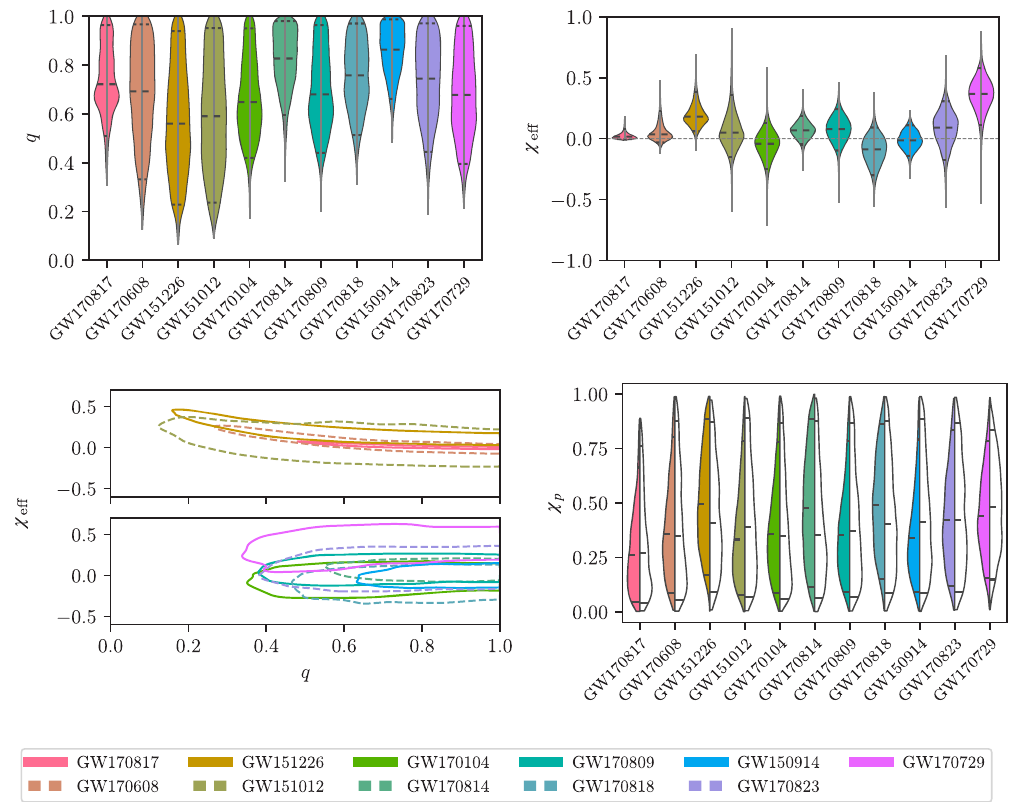
FIG. 5. Parameter estimation summary plots II. Posterior probability densities of the mass ratio and spin parameters of the GWevents. The shaded probability distributions have equal maximum widths, and horizontal lines indicate the medians and 90% credible intervals of the distributions. For the two-dimensional distributions, the contours show 90% credible regions. Events are ordered by source-frame chirp mass. The colors correspond to the colors used in summary plots. For GW170817, we show results for the high-spin prior a < 0 . 89 . Top left: The mass ratio q ¼ m =m χ . Bottom left: Contours of 90% i 2 1 . Top right: The effective aligned spin magnitude eff credible regions for the effective aligned spin and mass ratio of the binary components for low- (high-) mass binaries are shown in the upper (lower) panel. Bottom right: The effective precession spin posterior (colored) and its effective prior distribution (white) for BBH (BNS) events. The priors are conditioned on the χ posterior eff